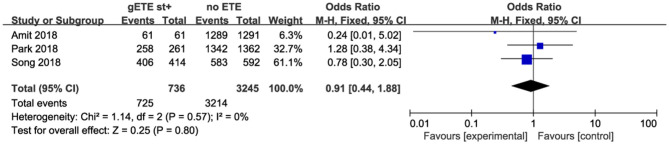
Forest plot for 10 year DSS comparison between gETE st+ with no ETE.